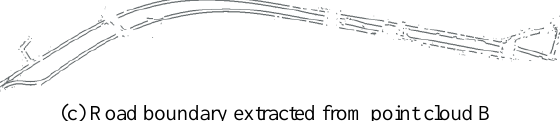
(c) Road boundary extracted from point cloud B Figure 7. Road boundaries extracted from point clouds captured under different